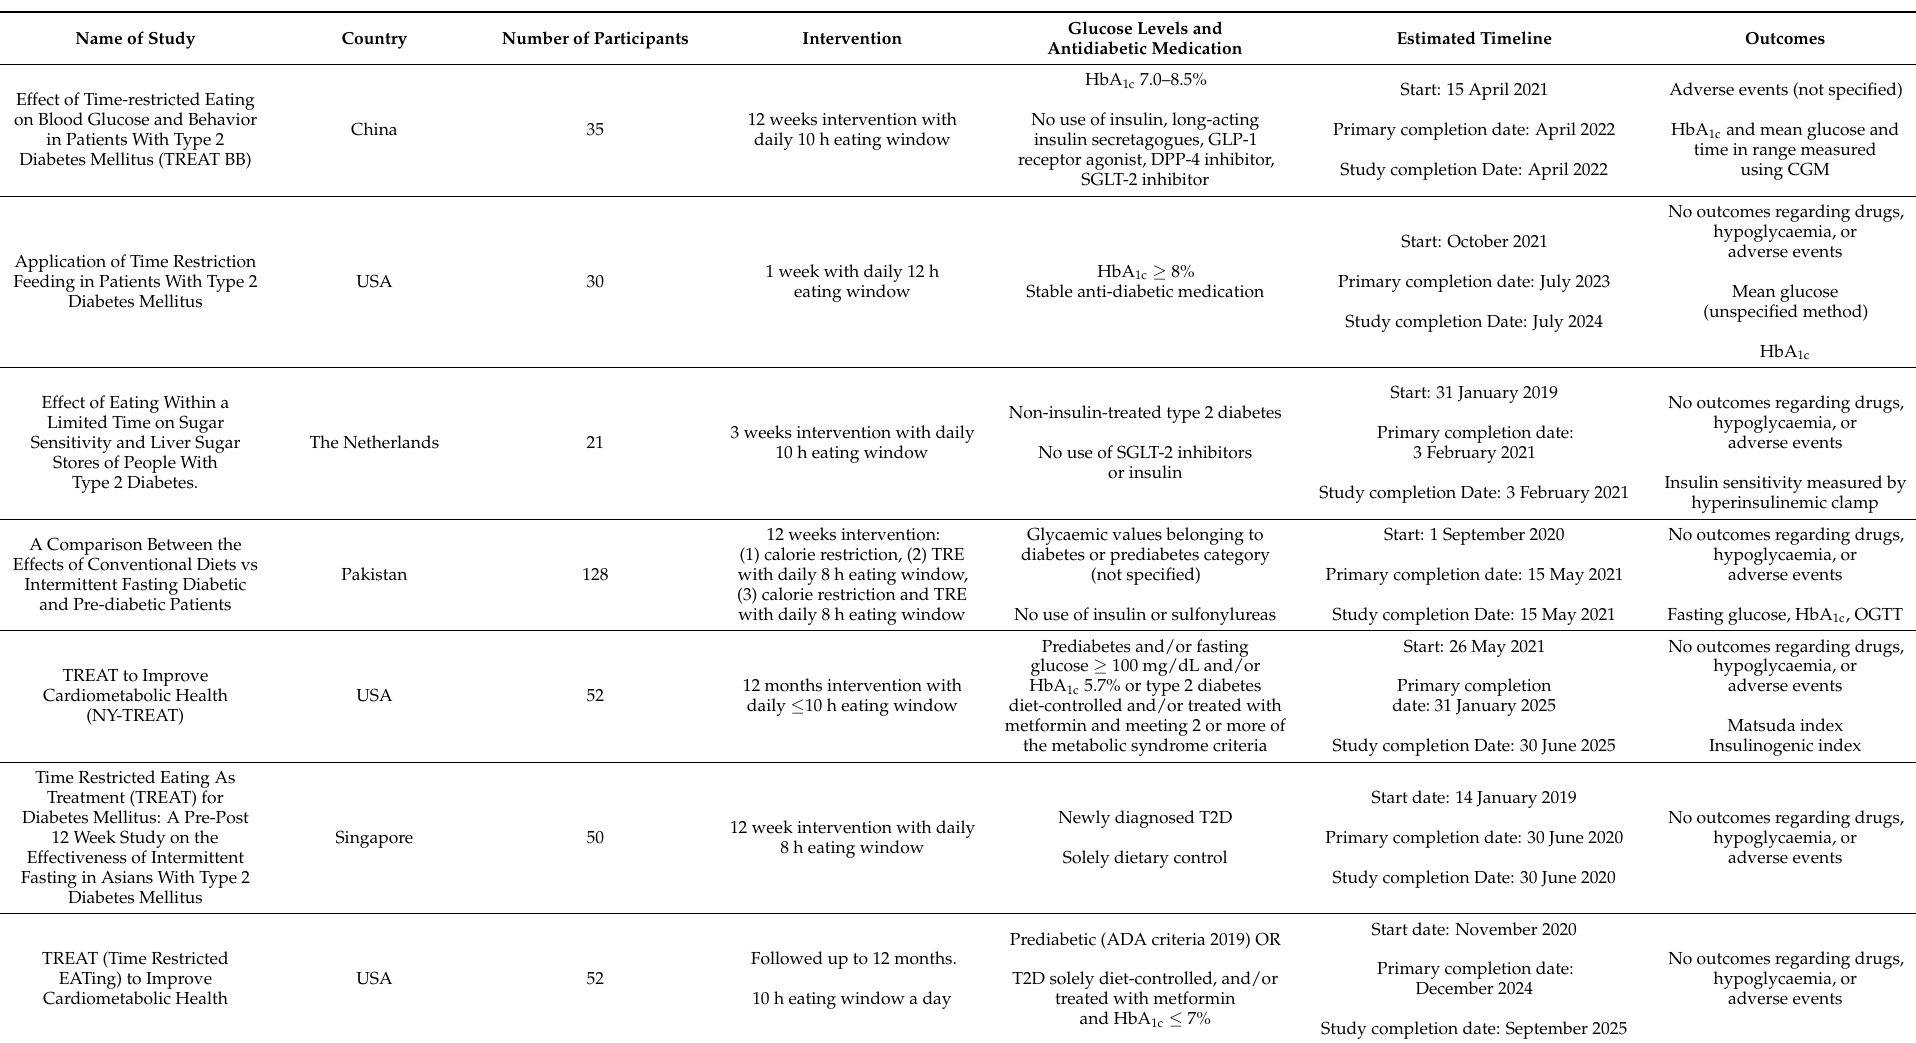
Table 2. Ongoing studies investigating time-restricted eating in people with type 2 diabetes registered on ClinicalTrials.gov, accessed on 21 December